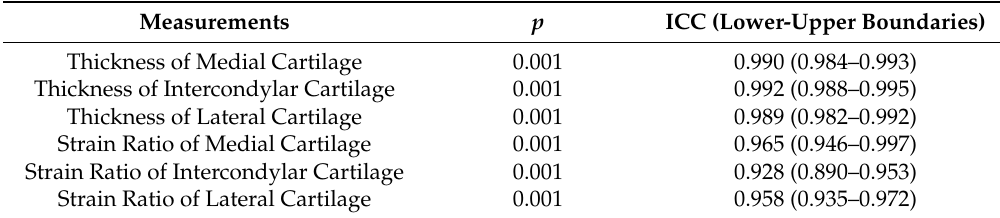
Table 2. Intrarater reliability of cartilage thickness and strain ratio